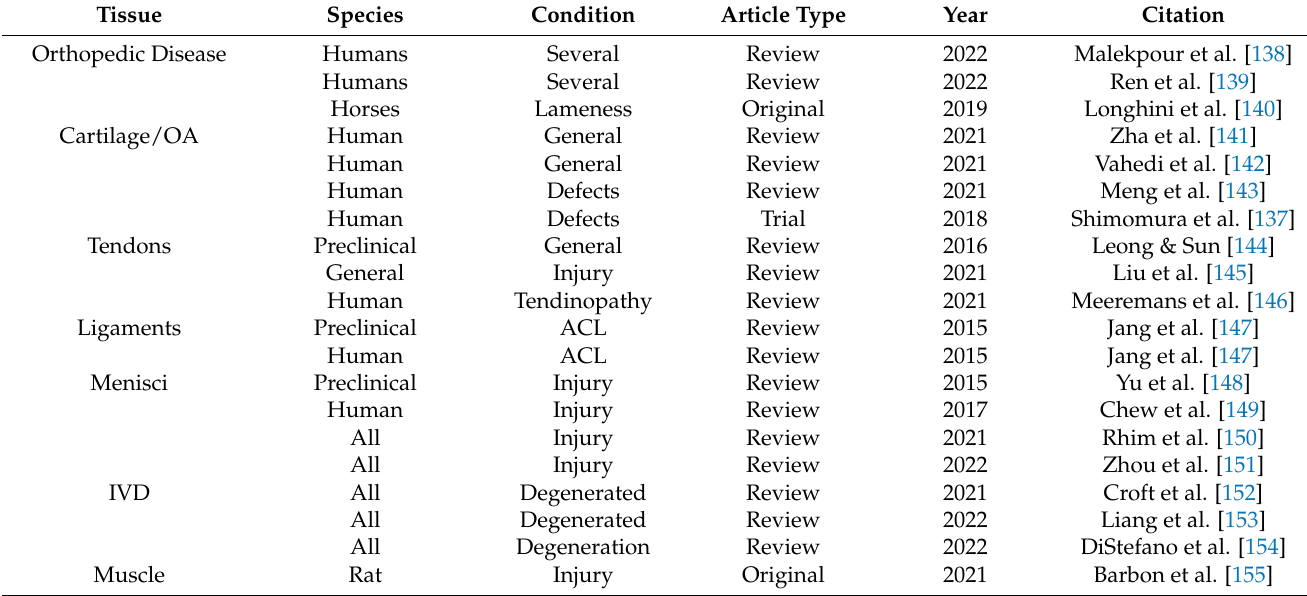
Table 2. Applications of Mesenchymal Stem/Progenitor Cells for Connective Tissue Repair and